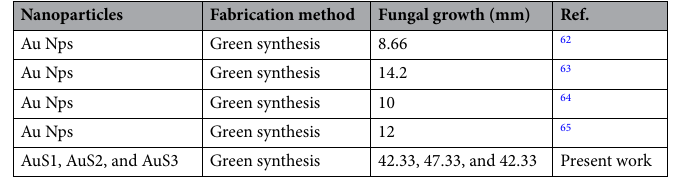
Table 5. Comparitive study of gold nanoparticles for antifungal efficiency against Fusarium